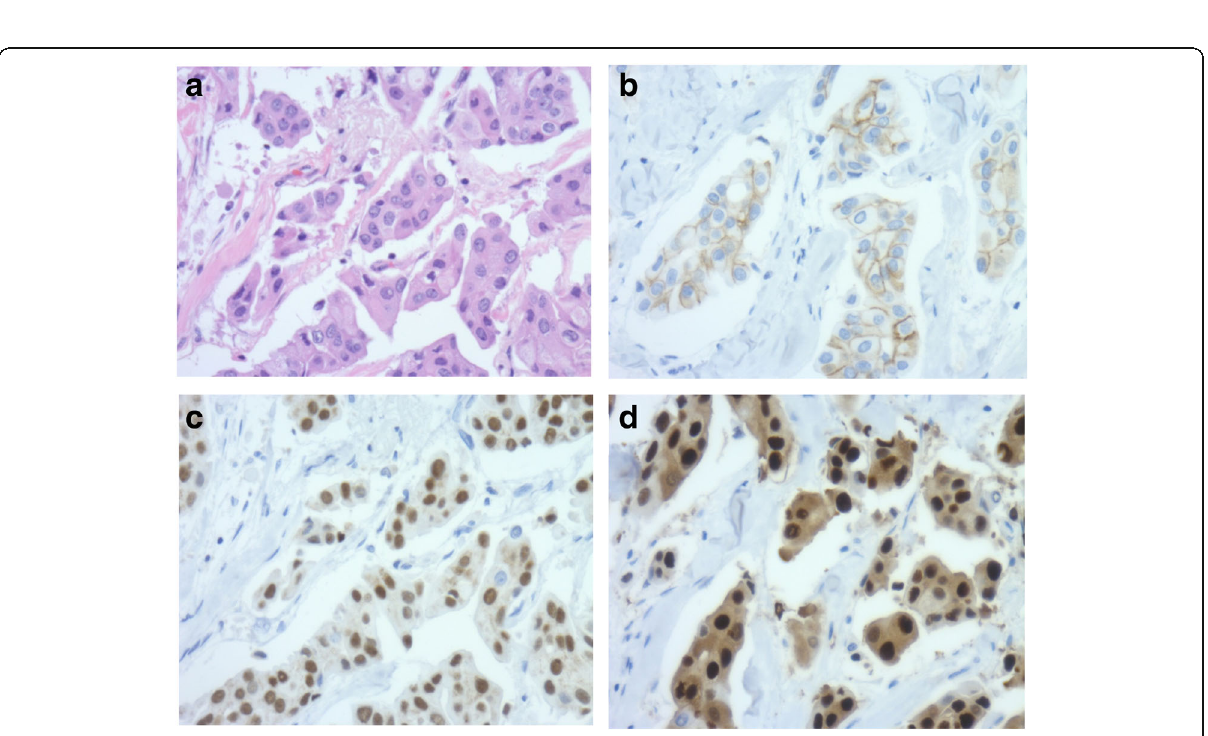
Fig. 4 MMG and US at the age of 57 years. a A spiculated mass was observed in the right breast. b The size of the irregular indistinct tumor in the right breast increased (20 × 20 × 11 mm) as shown by